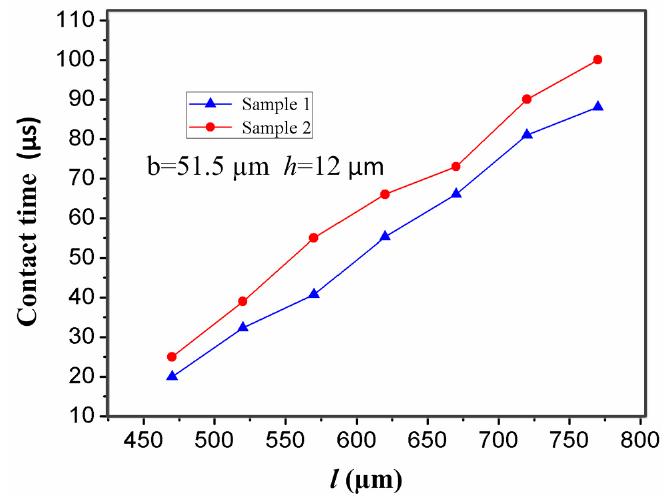
Figure 12. Dependence of contact time in samples 1 and 2 on the length ( l ) of the stationary electrode under the applied acceleration 288 g.